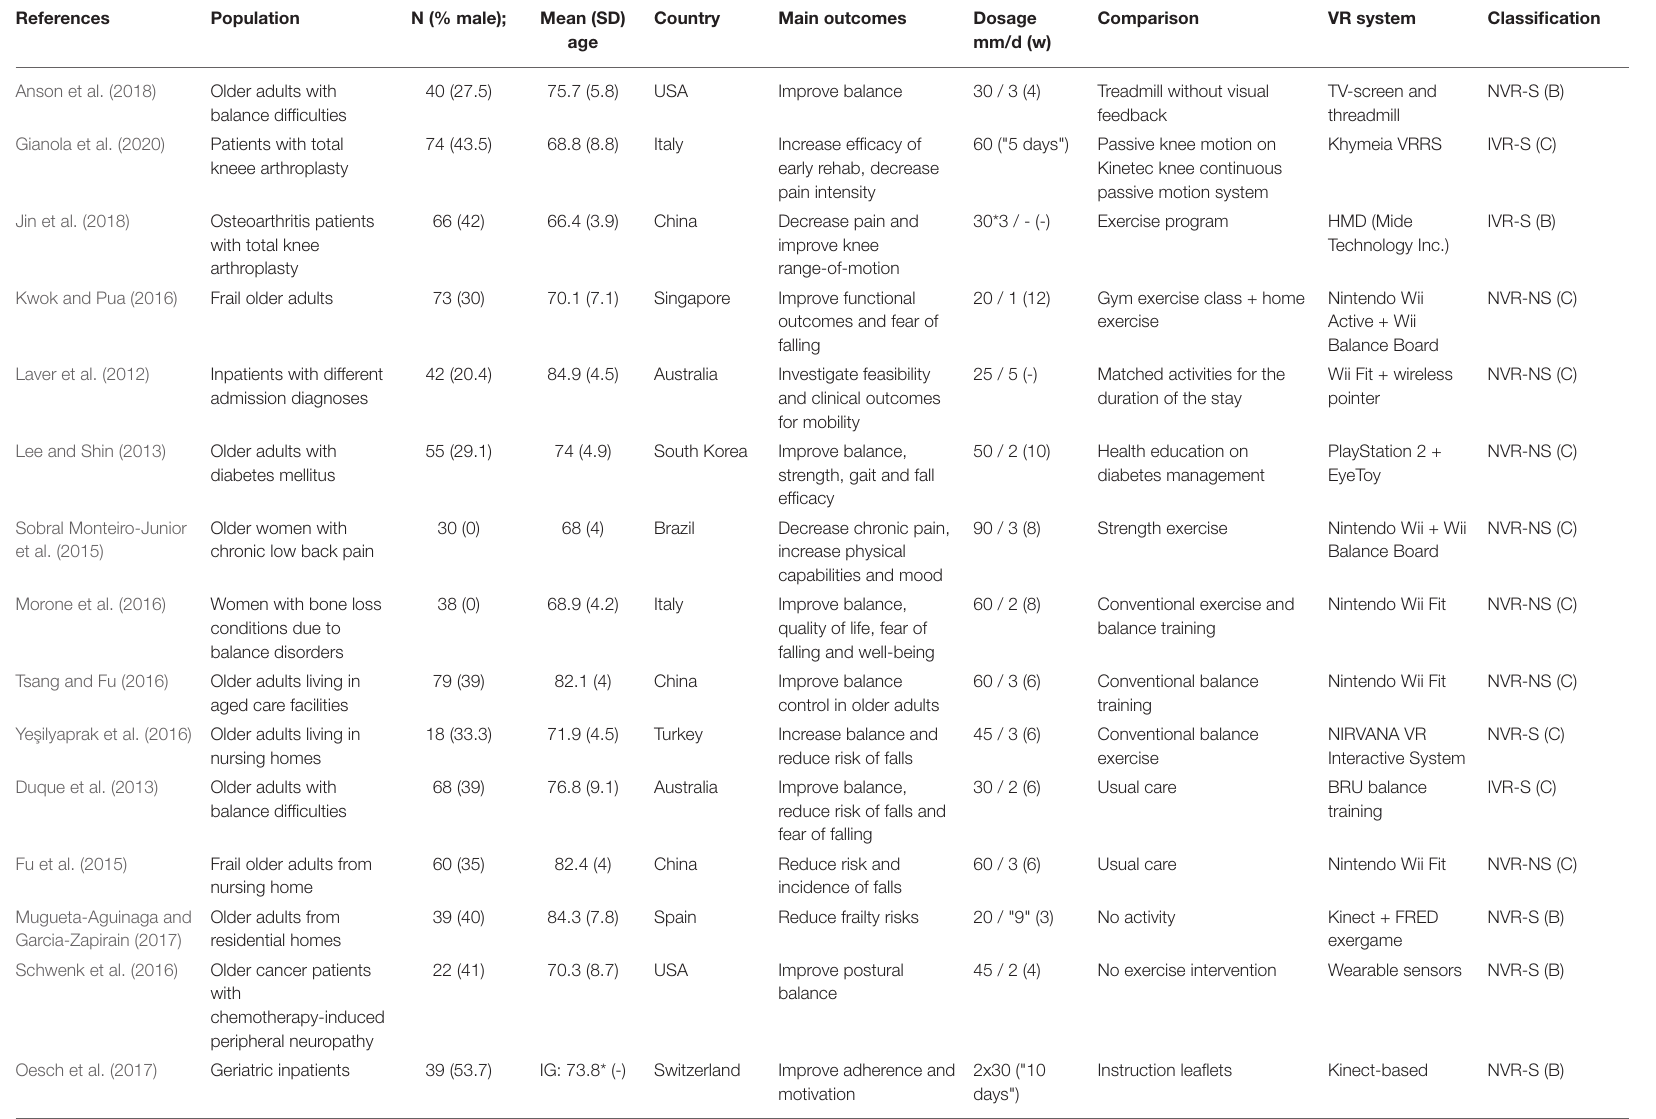
TABLE 1 | Characteristics of included